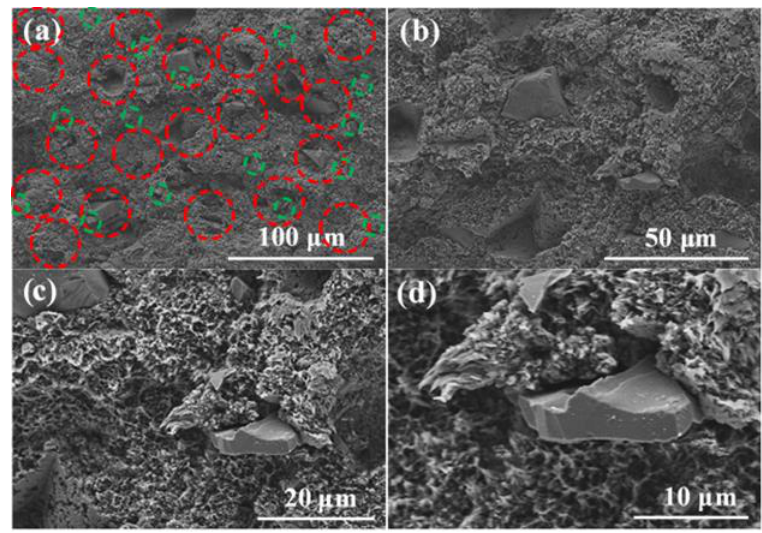
Figure 7. SEM photo of the cross-section of the B 4 C/TiO 2 /polyimide molded plate (Area 2). ( a ) B 4 C, TiO 2 particle distribution (100 μm), ( b ) B 4 C, TiO 2 particle distribution (50 μm), ( c ) B 4 C, TiO 2 particle distribution (20 μm), ( d ) B 4 C, TiO 2 particle distribution (10 μm).